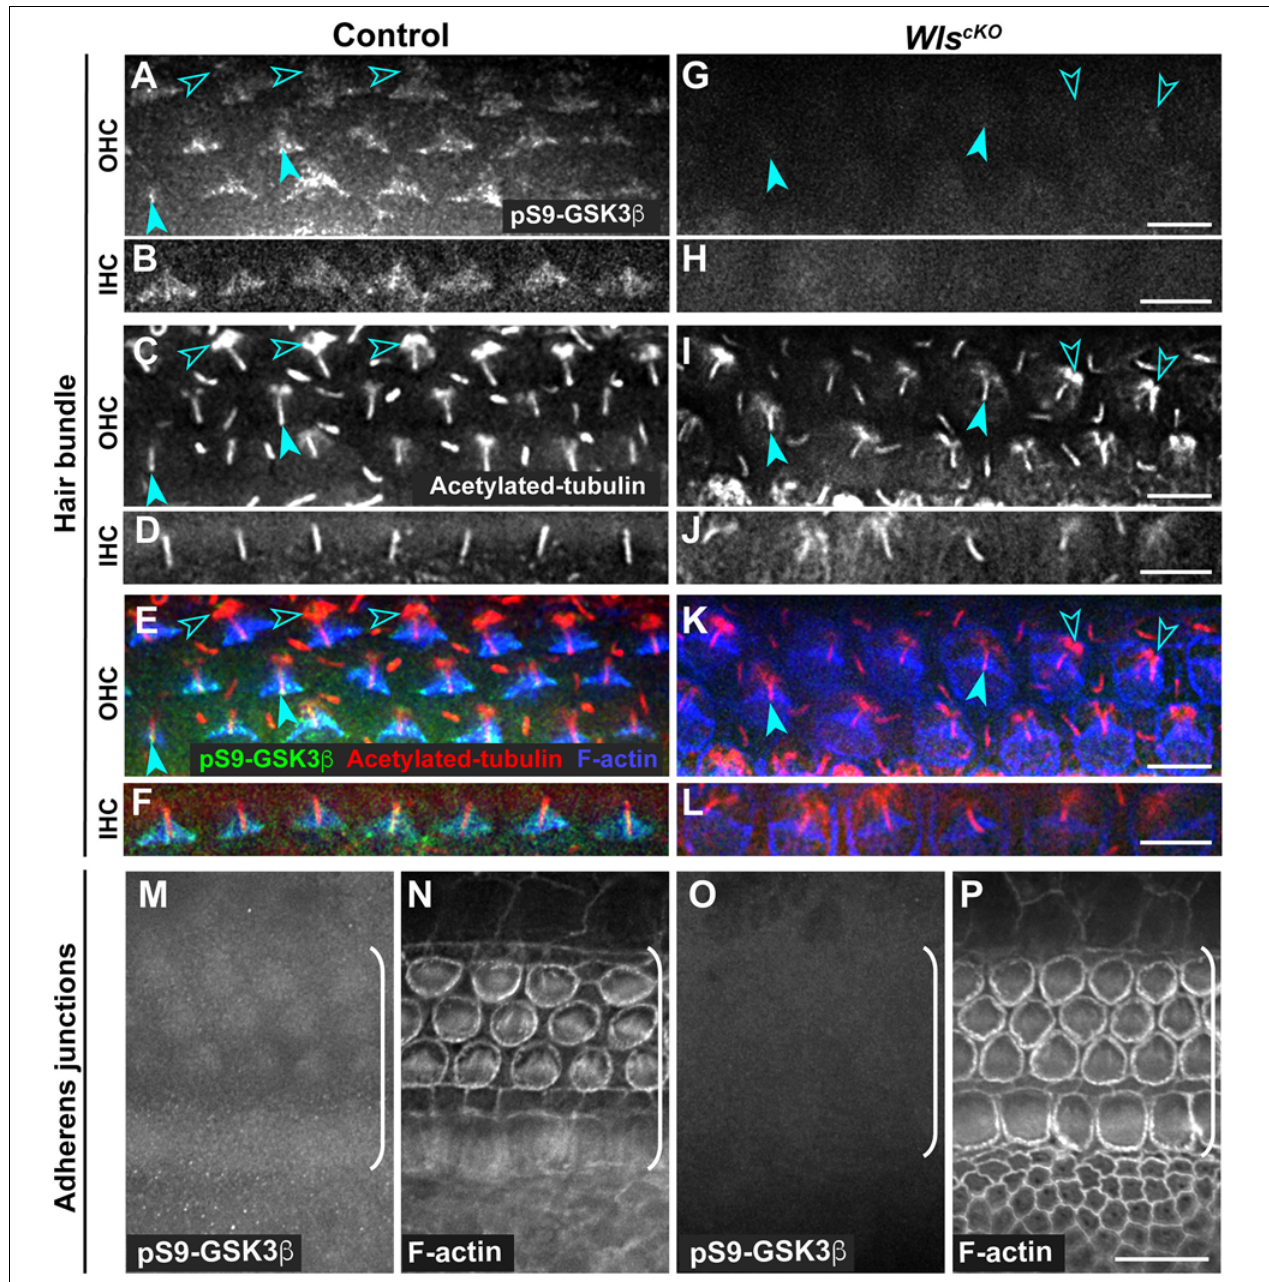
FIGURE 1 | Wnts promote inhibitory phosphorylation of Gsk3 β at Ser9 in the cochlea. (A–L) pS9-Gsk3 β (green), acetylated-tubulin (red), and phalloidin (blue) staining at the level of the hair bundle in control (A–F) and Wls cKO (G–L) OC at E18.5. Open arrowheads indicate the pericentriolar region. Arrowheads indicate the tip of the kinocilium. (M–P) pS9-Gsk3 β and phalloidin staining at the level of adherens junctions in control (M,N) and Wls cKO (O,P) OC and surrounding regions. Brackets indicate the OC. Lateral is up. Scale bars: (A–L) , 6 µ m; (M–P) , 10 µ